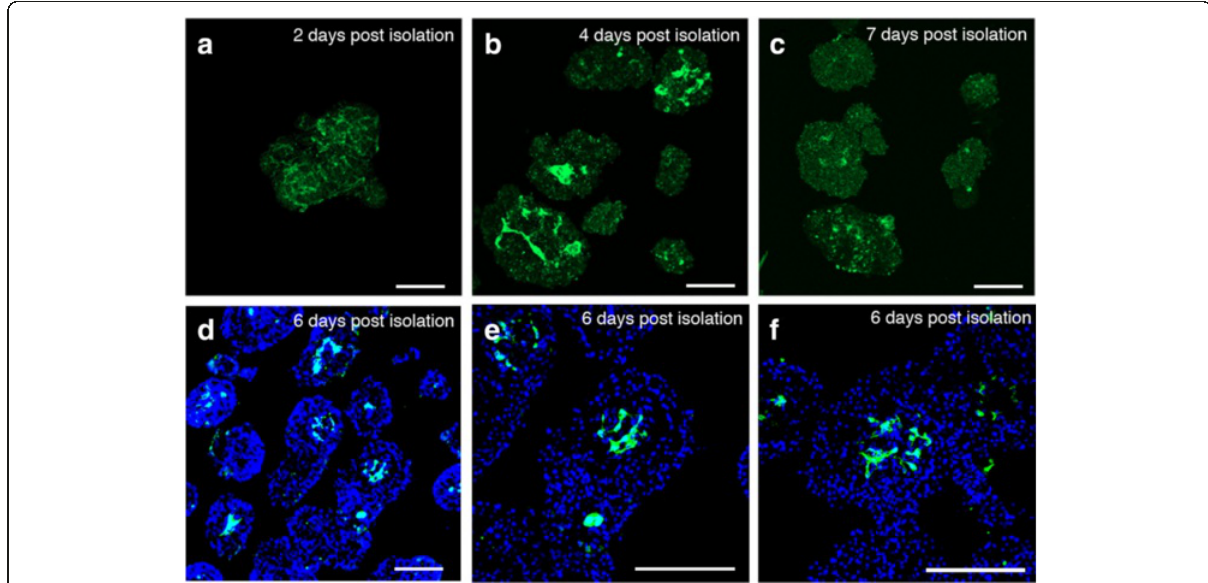
Fig. 5 Islet endothelial cell migration in cultured human islets in the absence of MSC. a In situ CD31 expression (green) two days after isolation showing vessels that are evenly spread throughout the islet. b After four days in culture after isolation, the vessels are withdrawn towards the center of the islet and after ( c ) one week in culture, the vessels are loosing their expression of CD31. d - f Sectioned human islets stained for CD31 (green) at 6 days after isolation. Nuclei stained by DAPI in blue. Bars = 100